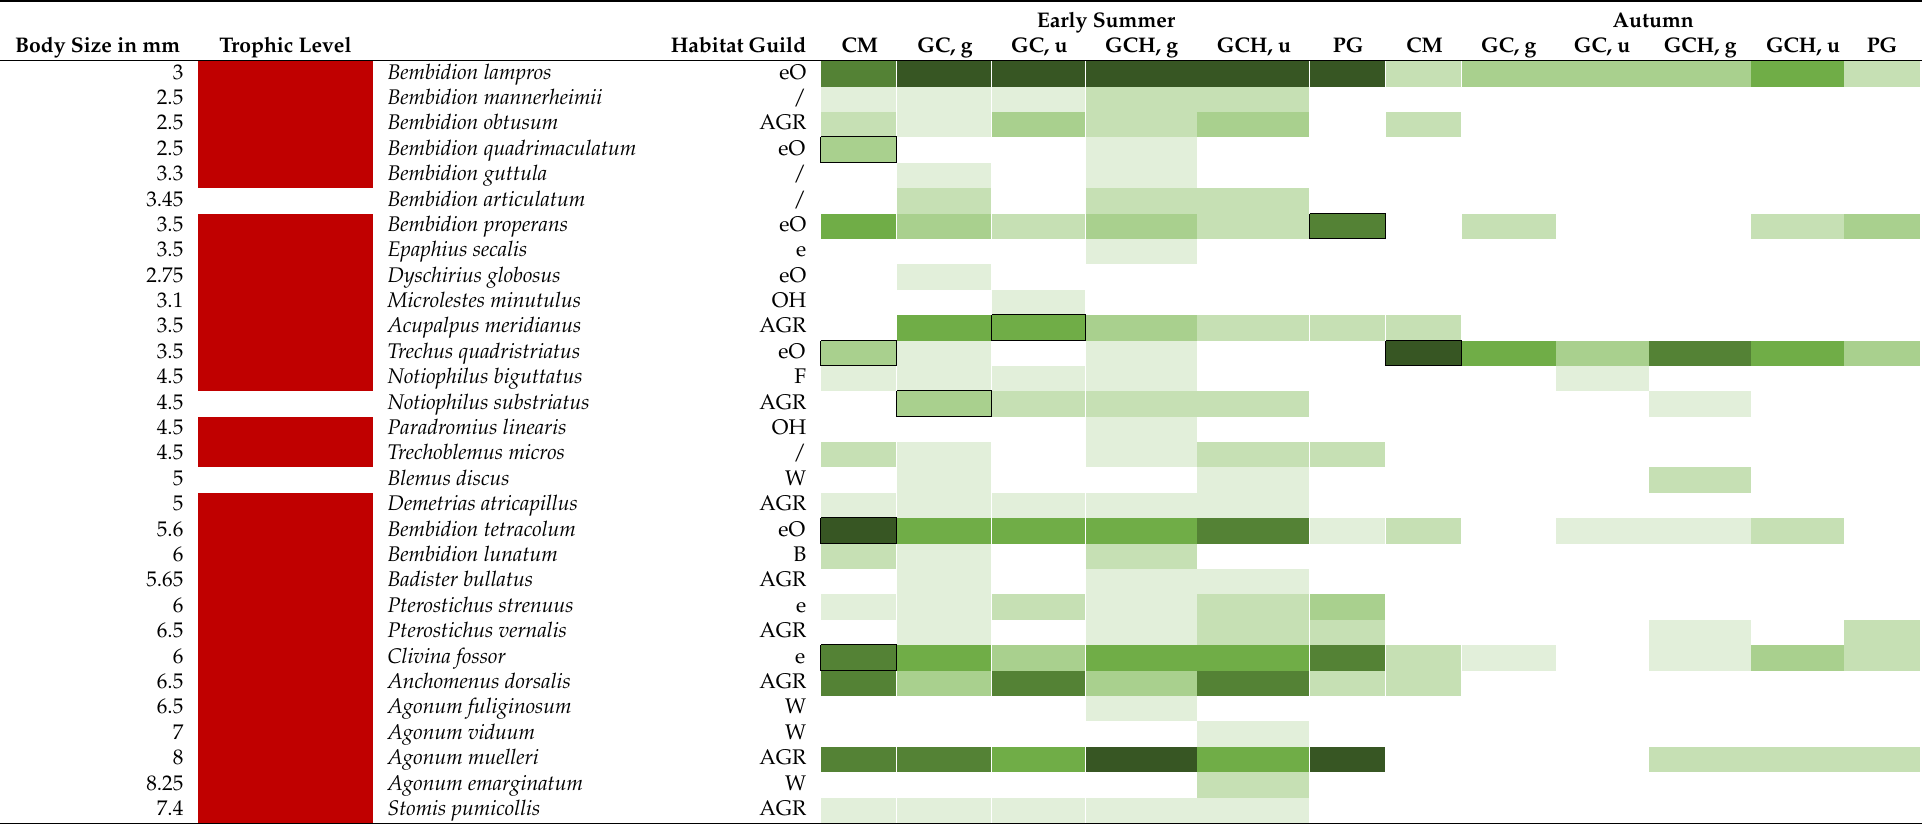
Table 1. Full species list of all carabid beetles caught in early summer and autumn, sorted by body size from small to large species. Trophic level (red: carnivorous species, yellow: herbivorous species) and habitat guilds (e: eurytopic, eO: eurytopic open-habitat, AGR: agrotopic beetles, W: wetlands, F: forest, OH: oligotrophic/heathland, S: swamp, B: banks, /: information on habitat guild missing), are indicated in the list. The heat map shows the activity density in the treatments (GC g: grass–clover grazed, GC u: grass–clover ungrazed, GCH g: grass–clover herbs grazed, GCH u: grass–clover herbs ungrazed, CM: conventional maize, PG: permanent grasslands). Cells with an outline in the heatmap show indicator species. Names of endangered species according to the red list of Schleswig-Holstein are in red text (3: endangered, 2: highly endangered, 1: risk of extinction, 0: